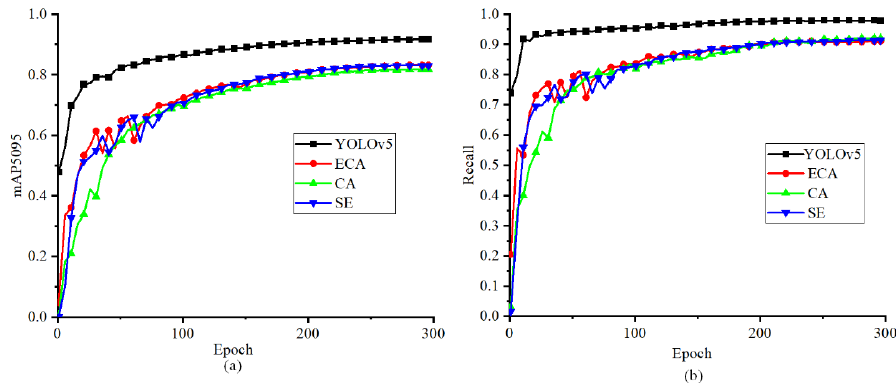
Figure 24. Variation trend of training metrics in the experiment. ( a ) mAP5095; ( b ) recall. Table 5. Performance comparison with the YOLOv5 model and the depth-attention YOLOv5 model.